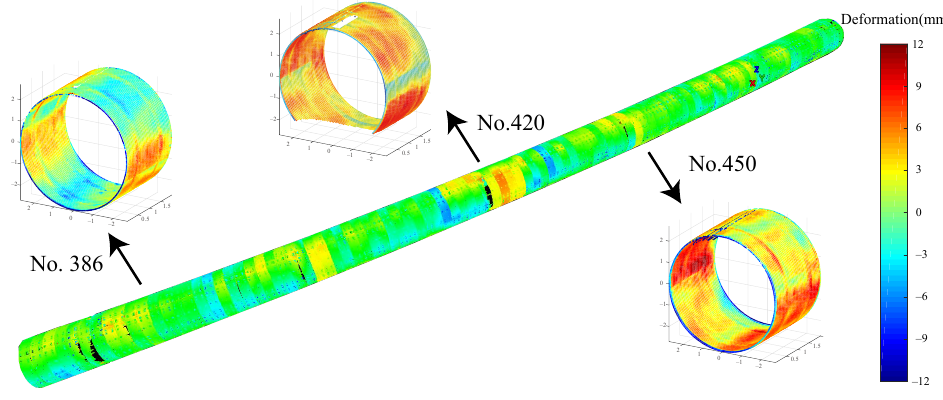
Figure 15. The overall deformation nephogram of Shanghai metro line